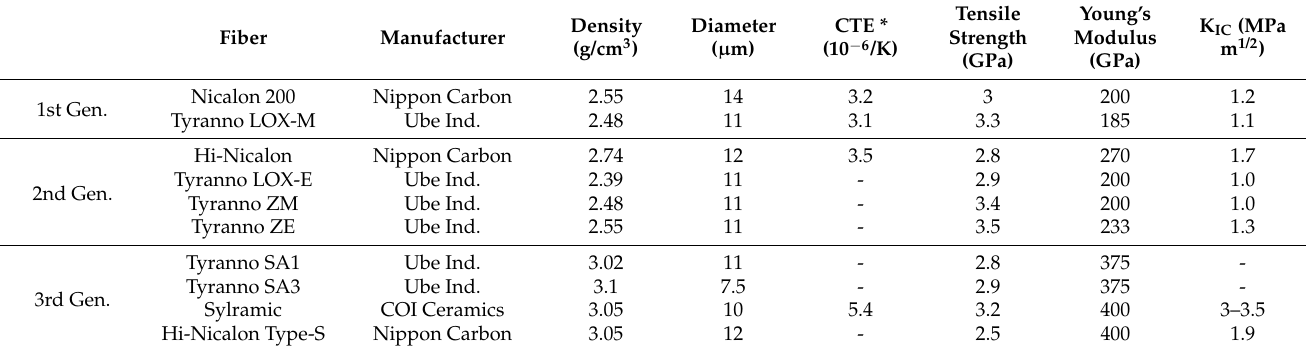
Table 1. Some key properties of the three generations of SiC-based fibers